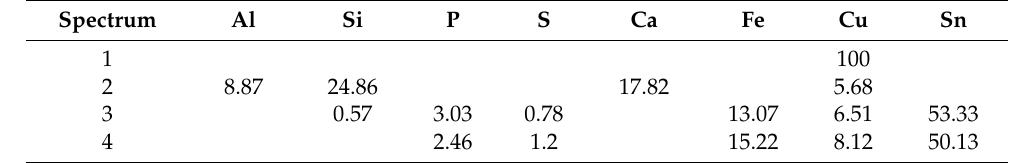
Figure 14. Micrographs (BSE-SEM) of a leached PCB (“fine” fraction), ( a ) and ( b ) BSE-SEM images of “fine” fraction. Table 4. EDS mapping of leached PCB (%) (“fine” residue shown in Figure 14a).